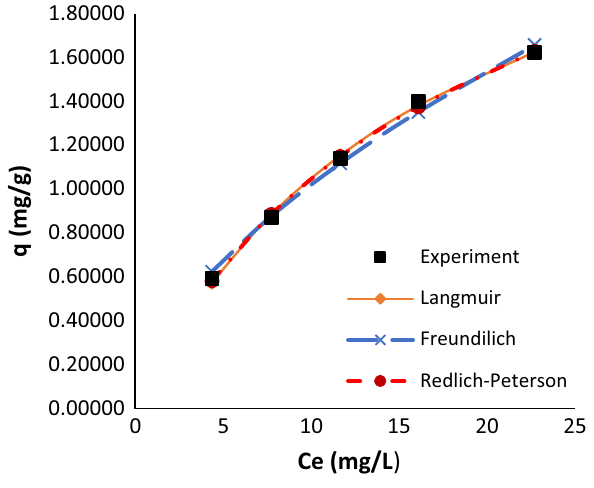
Fig.7 Predicted adsorption isotherm curve fits for cyanide adsorption onto activated periwinkle shell carbon